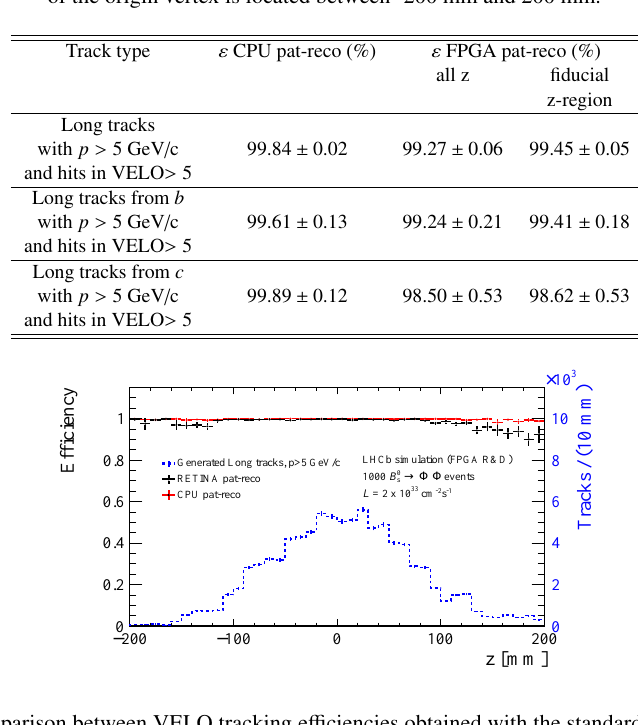
Figure 5. Comparison between VELO tracking e ffi ciencies obtained with the standard CPU algorithm and the retina patter recognition algorithm. The e ffi ciency is shown as a function of the z coordinate of the track origin vertex